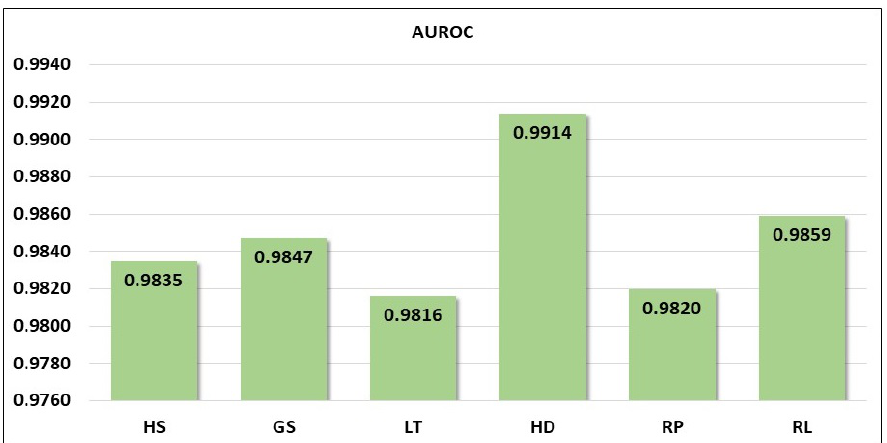
Figure 12. Area under the ROC for six motor events tested in the framework of